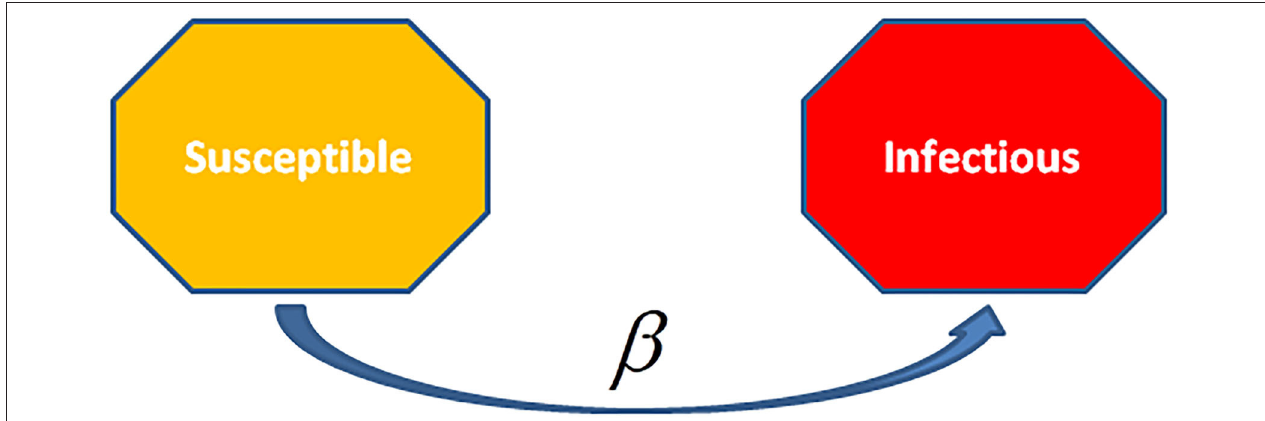
FIGURE 6 | The Susceptible- Infectious (SI) Model is the ingenious model among the disease models. Units are born without immunity which means they are susceptible to all infections. When they will be infected and not given any treatments, then all cases remain life-long infected, and they remained in contact with the susceptible population. This model applies to diseases such as cytomegalovirus (CMV) and